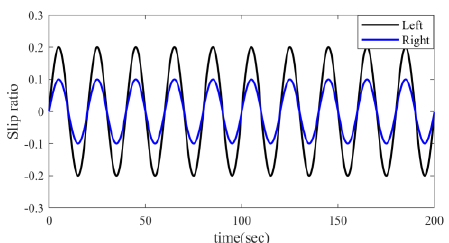
Figure 5. Slip ratio variations of the left and right tracks.